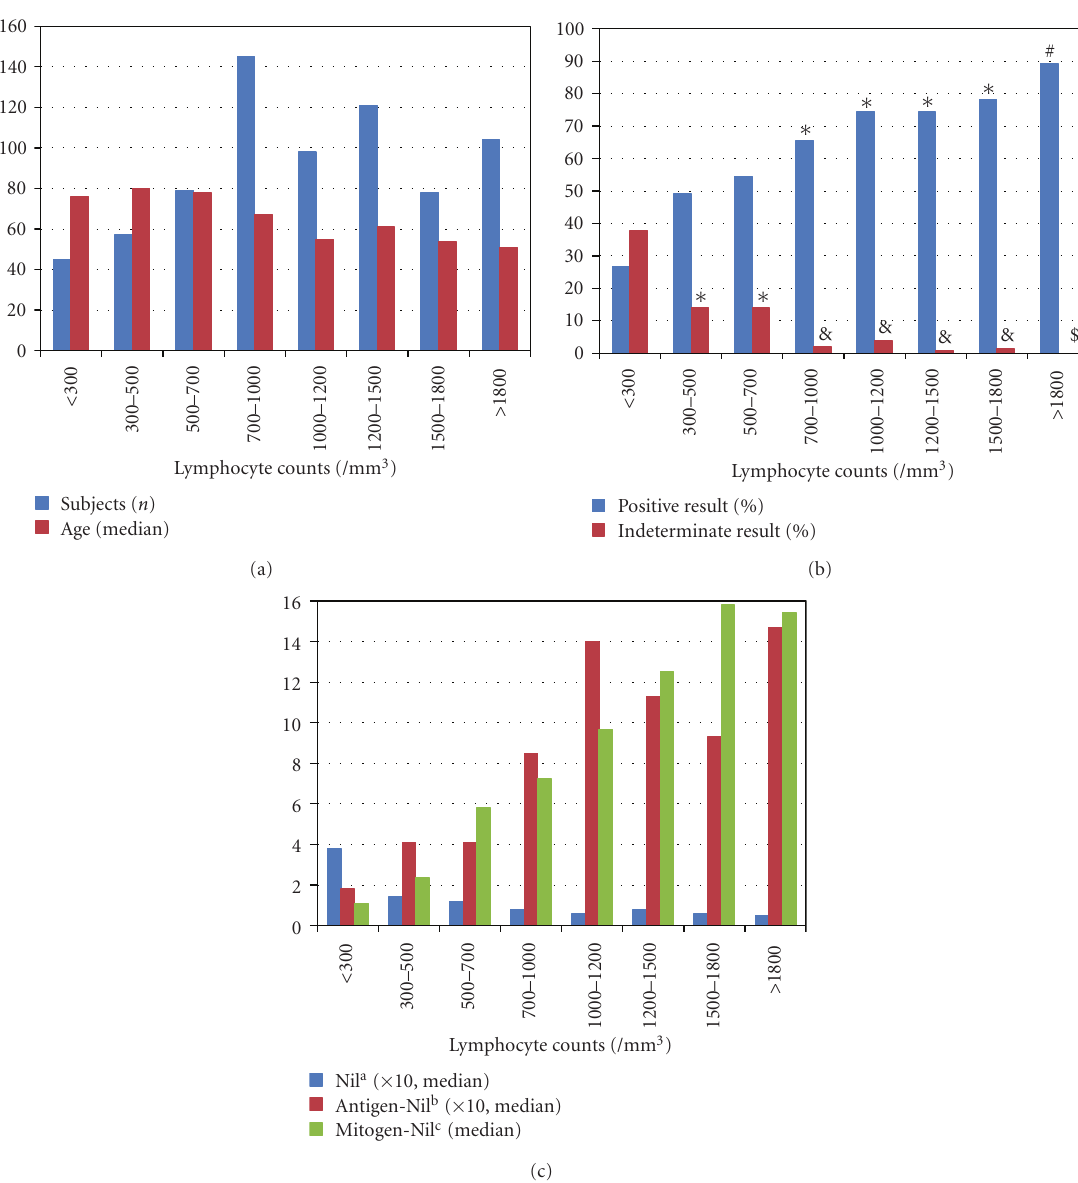
Figure 2: QuantiFERON-TB GOLD results in culture-proven pulmonary tuberculosis subgroups stratified by absolute number of peripheral blood lymphocyte. (a) Numbers and ages of patients divided into eight subgroups based on peripheral lymphocytes. (b) Proportion of QFT results with eight subgroups. ∗ : P < . 05 versus < 300/mm 3 category. & : P < . 05 versus < 300/mm 3 category, P < . 05 versus 300–500/mm 3 category, and P < . 05 versus 500–700/mm 3 category. # : P < . 05 versus < 300/mm 3 category, P < . 05 versus 300–500/mm 3 category, P < . 05 versus 500–700/mm 3 category, and P < . 05 versus 700–1000/mm 3 category. $ : P < . 05 versus < 300/mm 3 category, P < . 05 versus 300– 500/mm 3 category, P < . 05 versus 500–700/mm 3 category, P < . 05 versus 700–1000/mm 3 category, and P < . 05 versus 1000–1200/mm 3 category. (c) Antigen-stimulated and mitogen-stimulated IFN- γ responses with lymphocyte count (IU/mL). a : Nil (background) IFN- γ concentration. b : Di ff erence between the higher IFN- γ concentration after stimulation with either antigenic peptides ESAT-6 or CFP-10 and nil (background) IFN- γ concentration. c : Di ff erence between the determined IFN- γ concentration after stimulation with mitogen and the nil (background) IFN- γ